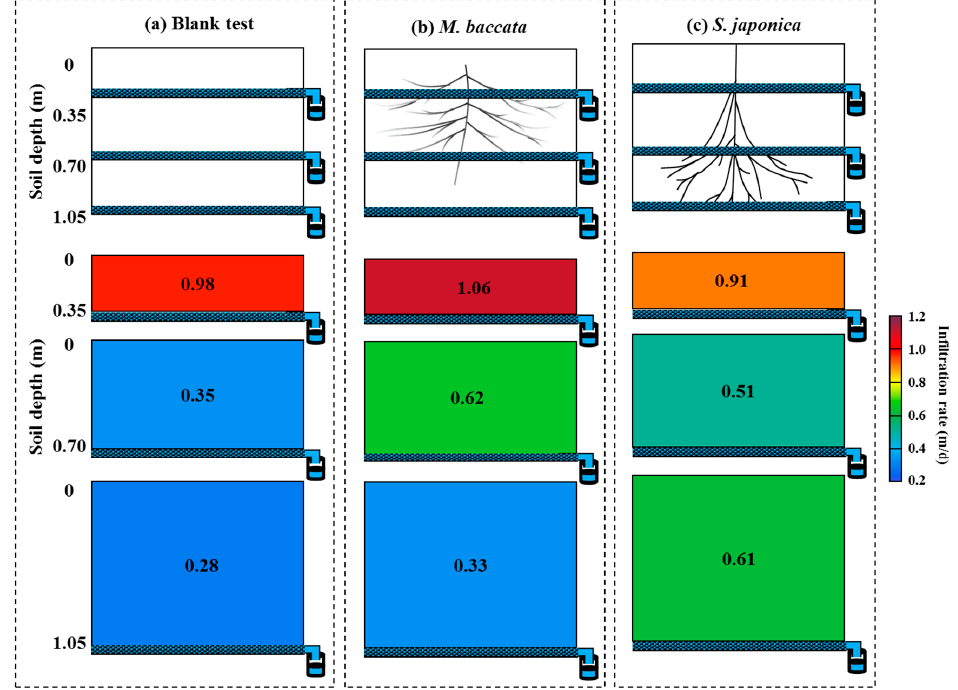
Figure 6. Mean soil infiltration rates at different depths in the three test tanks: ( a ) blank test, ( b ) M. Figure6. Meansoilinfiltrationratesatdi ff erentdepthsinthethreetesttanks: ( a )blanktest, ( b ) M.baccata , baccata , and ( c ) S. japonica . In each test, outflows from only one depth were used. and ( c ) S. japonica . In each test, outflows from only one depth were Tree roots were observed to improve the soil infiltration rate in the vertical direction compared to the soil in the blank test. Comparing the soil infiltration rate depths of 0.35 m and 0.70 m, the mean I of the soil in the blank test decreased by 64%, but decreased by only 41% ( M. baccata ) and 44% ( S. japonica ) when trees were planted. The relative I of the soil decreased less with an increase in soil depths when trees were present, indicating that the permeability of deeper soils was improved by tree roots. Tree roots can enlarge and generate pores in soils, which reduce the density of the soil and increases the infiltration rate [14,15]. In addition, M. baccata has a larger influence on the mean I of soil (1.06 m/d to 0.62 m/d) compared with S. japonica (0.91 m/d to 0.51 m/d) in the upper layer (i.e., for measurements taken at 0.35 m and 0.70 m). The same trend was obtained by other tanks in which M. baccata and S. japonica were planted. Pohl et al. [30] found that different trees with root systems that provided different functions had different geometries (e.g., root depths and horizontal root spreading), and that these different geometries may be important for soil permeability. M. baccata has mainly fibrous and lateral roots [47–49], and this root system dominantly changed the permeability of surface soils in the experiments of this study. In contrast, S. japonica has mainly tap roots [45,46], which penetrate deeply into the soil. This root system was shown to change the permeability of deep soils in the experiments of this study. 3.3.2. Infiltration Rates at Different Distances from Tree Trunks The infiltration rates at different distances from the tree trunks in the three test tanks were determined. The values were measured by four vertical monitoring tubes at the same distances away from the tree trunks (tubes “02”–“05” were at a distance of 0.65 m; tubes “06”–“09” were at a distance of 1.3 m). The mean infiltration rate ( I ) of the soil (Table S2, Figure 7) at a distance of 0.10 m from the tree trunks of M. baccata and S. japonica increased to 0.14 m/d and 0.19 m/d, respectively, compared with the blank test soil (0.11 m/d). Additionally, I also increased to 0.48 m/d and 0.52 m/d at a distance of 0.65 m from the tree trunk compared to the blank test soil (0.31 m/d), and increased to 0.80 m/d and 0.84 m/d at a distance of 1.30 m from the tree trunk compared to the blank test soil (0.44 m/d).